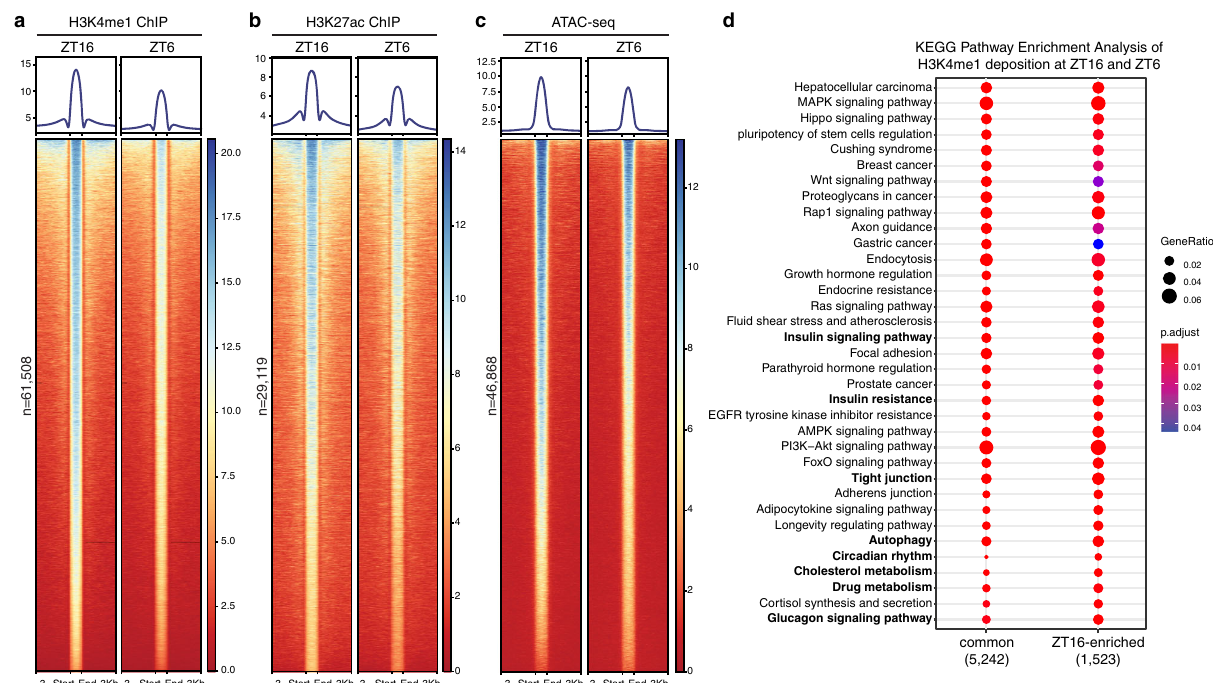
Fig. 5 Mouse liver chromatin is more accessible at night, synchronized with HNF4A recruitment. a – c Heatmap of H3K4me1 ChIP-seq ( a ), H3K27ac ChIP-seq ( b ), or ATAC-seq ( c ) signals within liver tissues sampled at ZT16 (left) or ZT6 (right) and centered at all peaks of ZT16. Peaks are ordered vertically by signal strength. d KEGG pathway analysis was performed for genes having ZT16-ZT6-common or ZT16-enriched H3K4me1 peaks as de fi ned in Supplementary Fig.